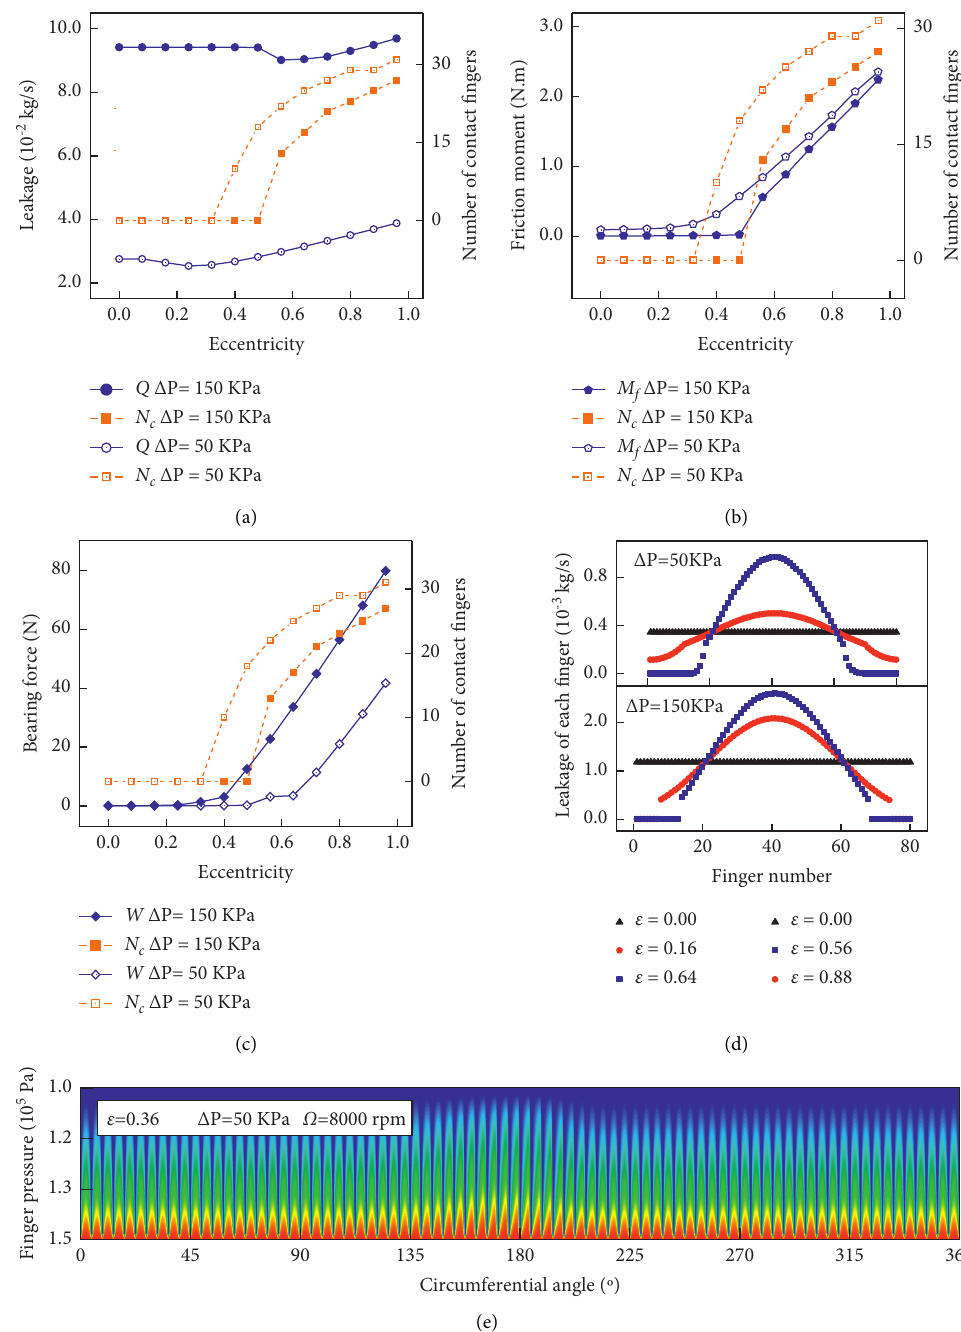
Figure 11: Effect of eccentricity. (a) Leakage for various eccentricities. (b) Friction moment for various eccentricities. (c) Bearing force for various eccentricities. (d) Leakage of each finger. (e) Pressure distribution of each